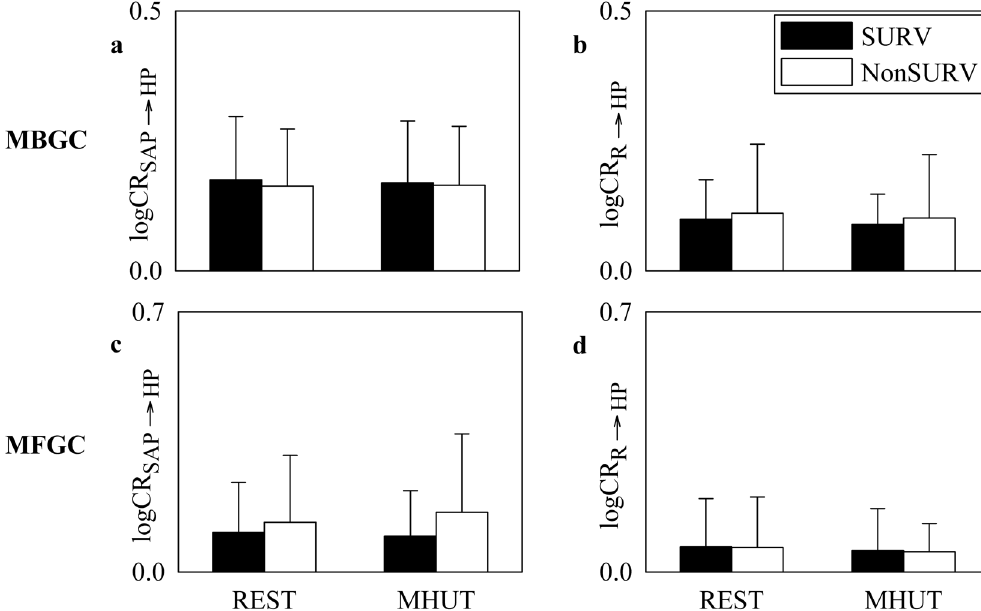
Figure 6. The bar graphs show → logCR ( a , c ) and → logCR ( b , d ) computed via MBGC ( a , b ) and SAP HP R HP MFGC ( c , d ) methods as a function of the experimental condition (i.e. REST and MHUT) in SURVs (dark bar) and NonSURVs (white bar). Data are reported as mean plus standard deviation.